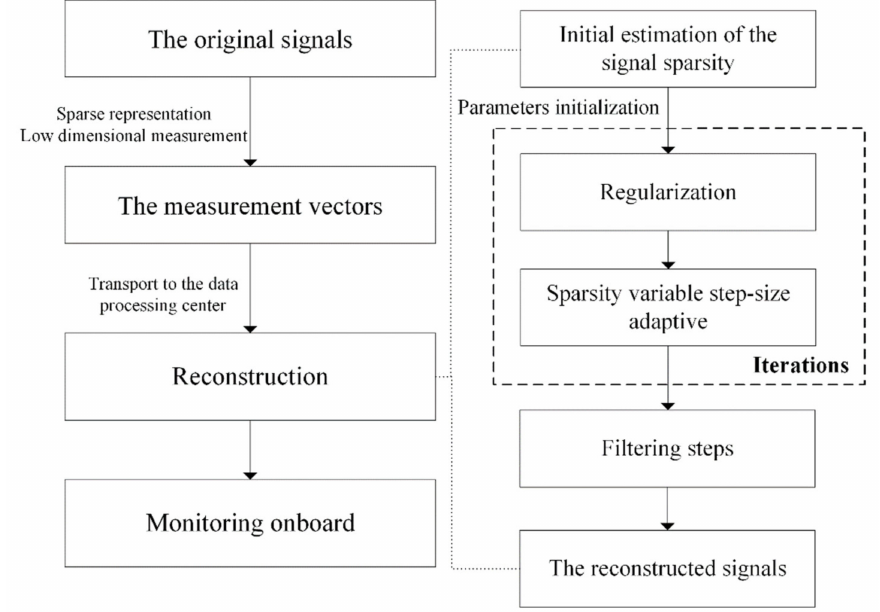
Figure 2. The implementation of vehicle health monitoring with